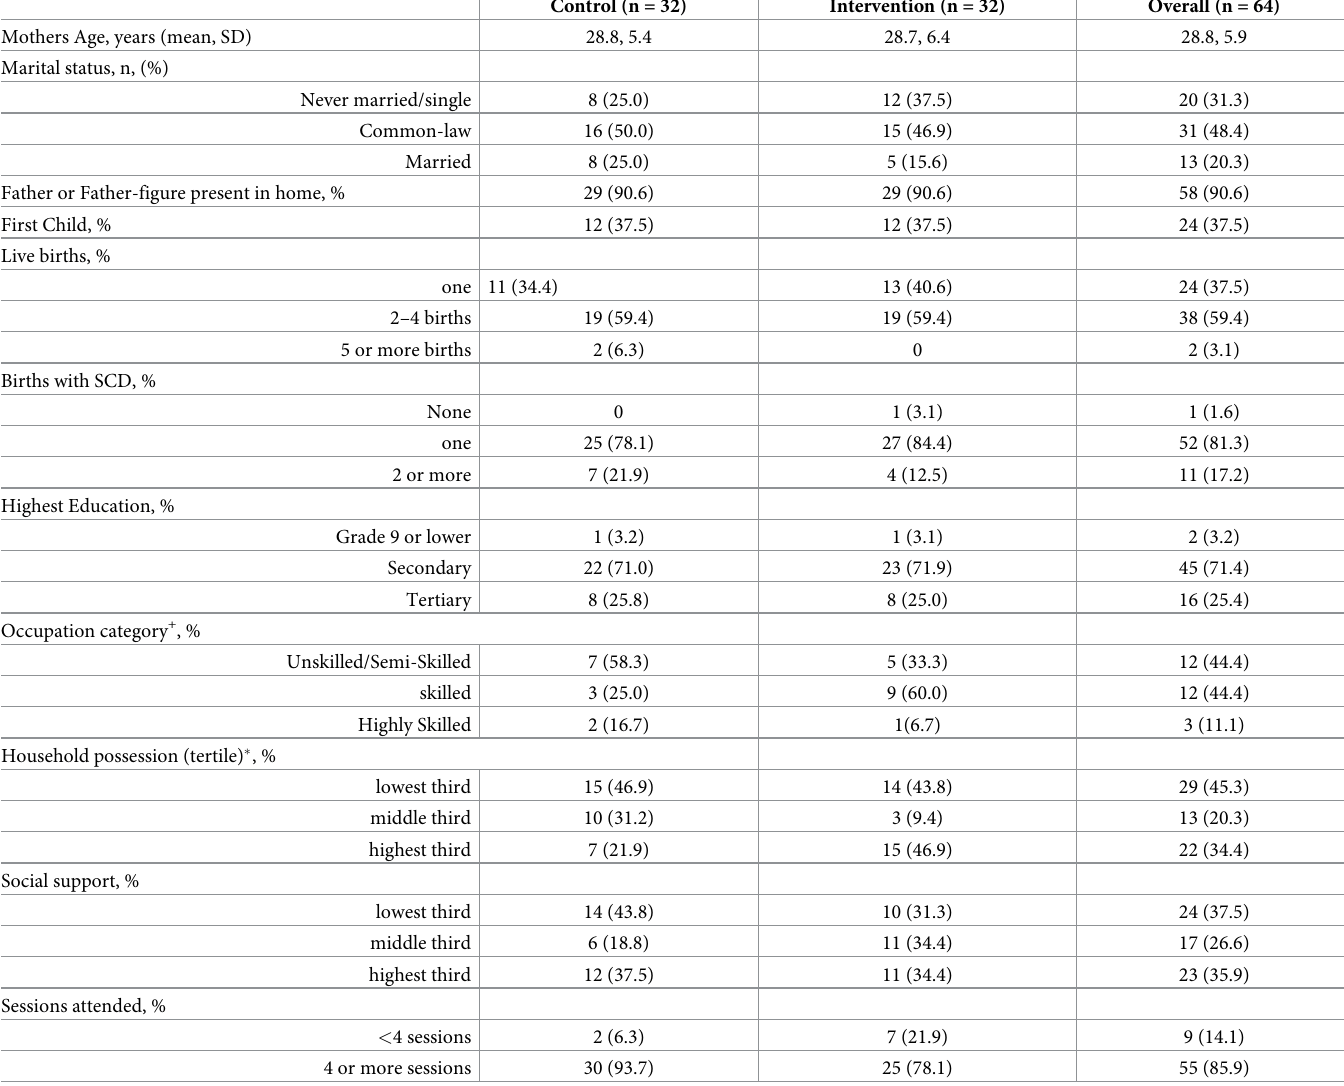
Table 1. Baseline maternal and home characteristics of control and intervention